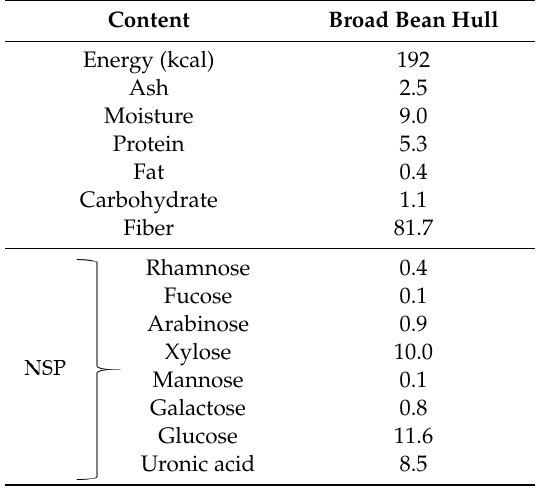
Table 3. Proximate composition of BBH powder.